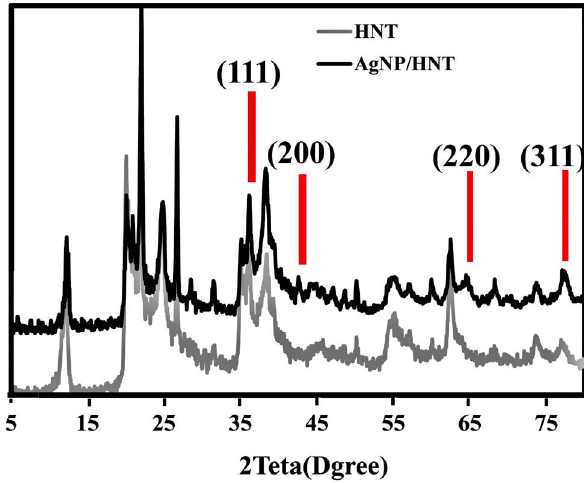
Fig 7. XRD pattern of HNTs and Ag/HNTs.